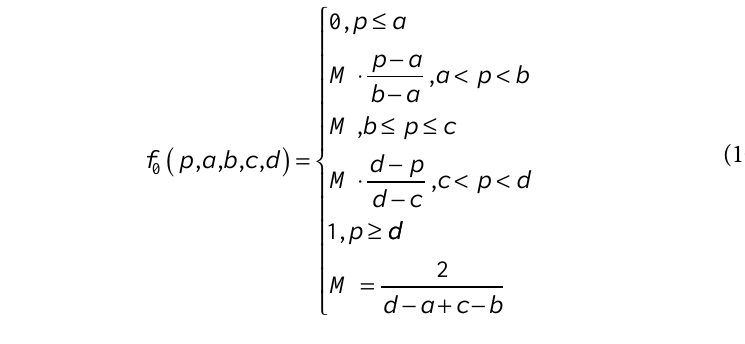
Fig. 4. Knowledge level density function of low ability ( f 0 ( p , 0, 0.25, 0.45, 0.7)), middle ability ( f 0 ( p , 0, 0.25, 0.75, 1)) and high ability ( f 0 ( p , 0.4, 0.6, 0.8, 1)), population